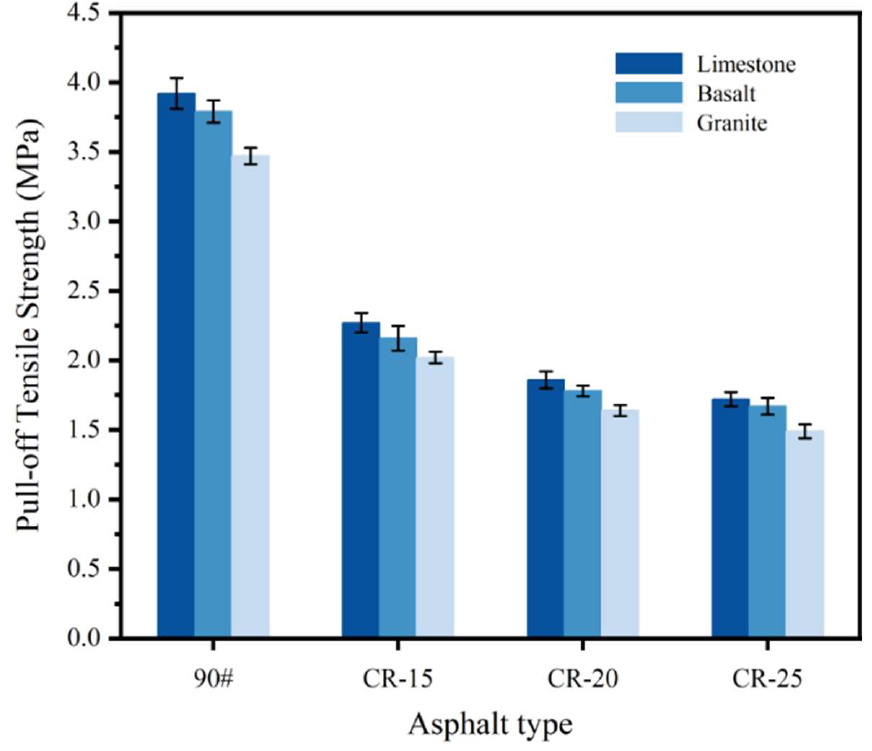
Figure 6. BBS test results of different rubberized asphalts.